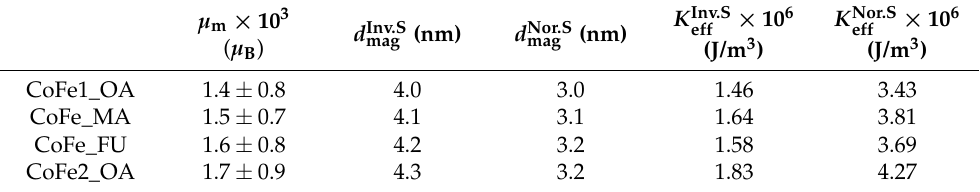
Table 3. Summary of the basic magnetic parameters of all samples, derived from the static mag- netization measurements: µ m —mean magnetic moment per particle, d mag —magnetic size, and K eff —effective magnetic anisotropy, calculated for the inverse (Inv) and normal (Nor) spinel